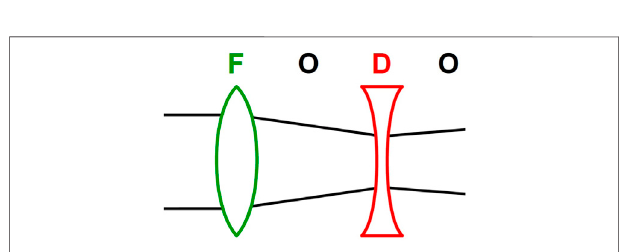
FIGURE 4 | Schematic depiction of a FODO cell, showing a transverse projection of the beam envelope undergoing focusing (F), drift (O), defocusing (D) and drift